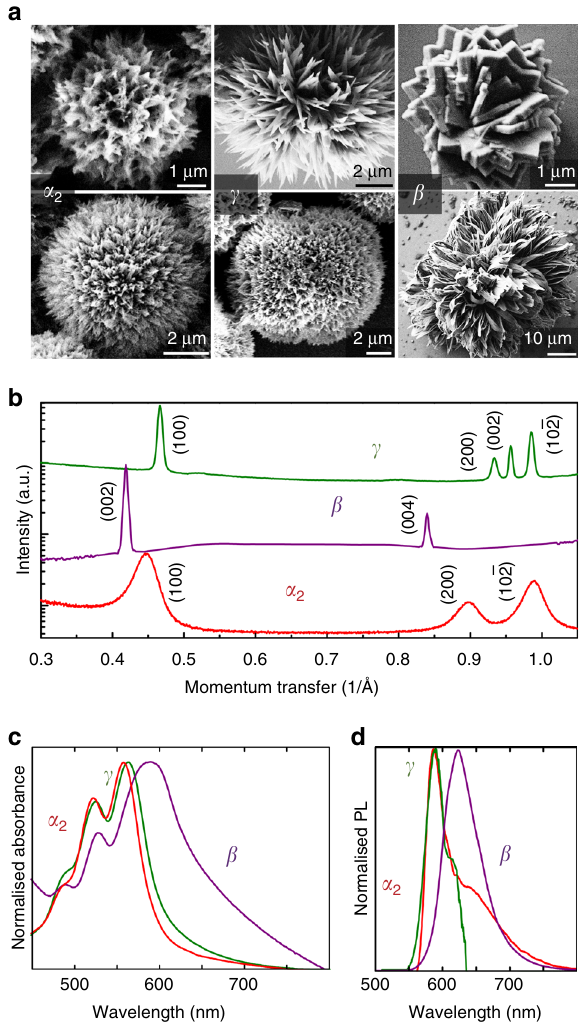
Fig. 3 Control of internal crystal structure. Polymorphism can be controlled by modulating reaction time and coordinating chemical additives. a SEM micrographs of α 2 , β and γ crystals. b X-ray diffraction, con fi rming the phase-pure quality of the colloidal samples, c absorbance and d luminescence of each sample. The upper row of SEM images shows the hierarchical nano-dagger modi fi cation, while the lower row shows hierarchical nanoneedle